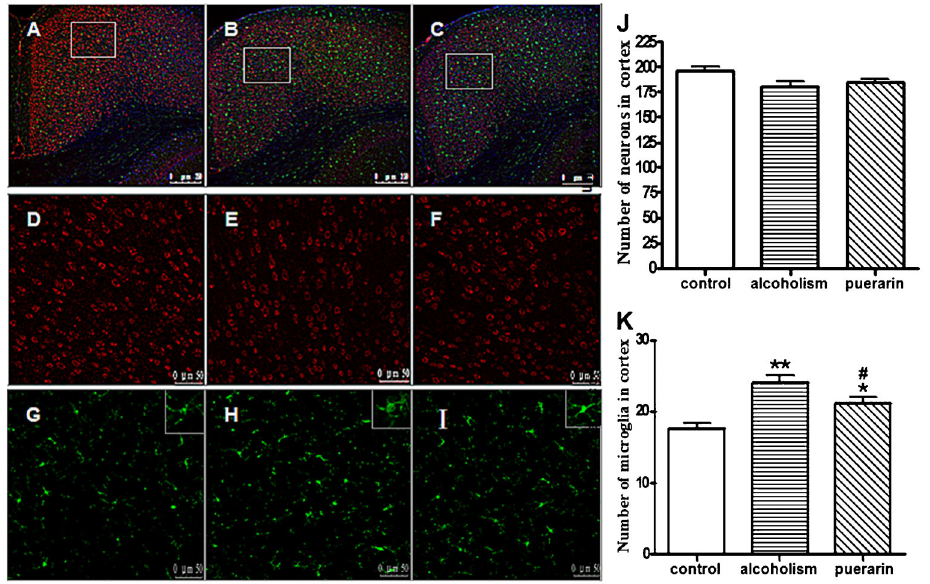
Figure 3. Detection of neuron and microglial cells in cortex of mice by immunohistochemical staining. A - C , Iba-1 immunofluorescence staining in the cortex of the control, model and puerarin groups (10 6 ). D - F , Cortical neurons of each group. G-I , Cortical microglia of each group. J , Number of neurons in the cortex of each group. K , Number of microglia in the cortex of each group. *P , 0.05, **P , 0.01 vs control group; # P , 0.05 vs model group (one-way